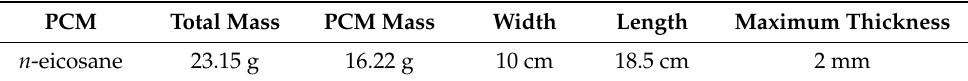
Table 3. Summary of the LHTES module’s properties.